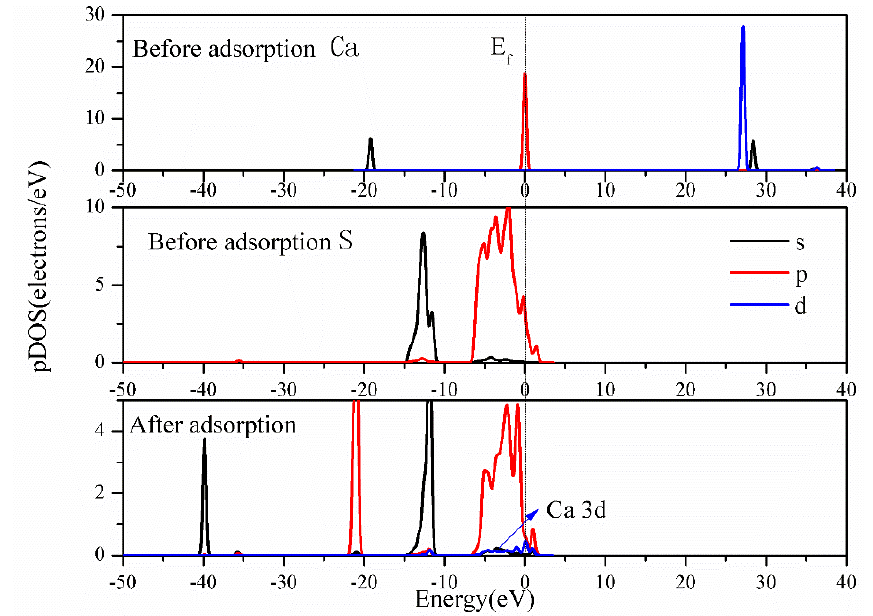
Figure 12. PDOS results of S atoms and the Ca atom before and after Ca 2+ adsorption on the molybdenite (100) surface.